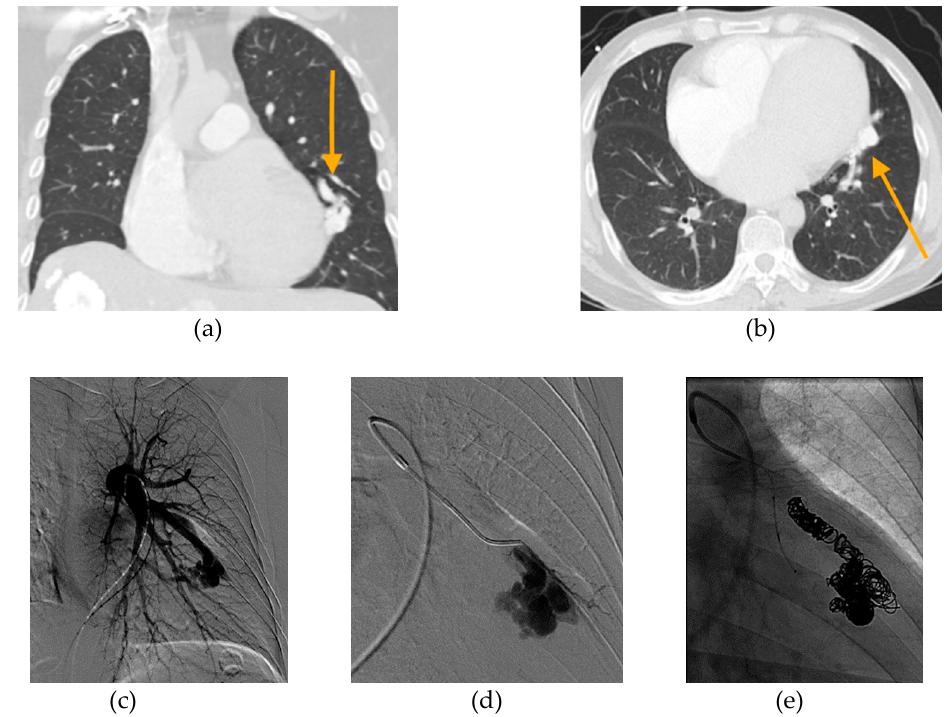
Figure 5. 49-year-old male with history of nonischemic cardiomyopathy, severe mitral and triscuspid regurgitation, PAVM, and PH presented with acute hypoxemic respiratory failure. ( a ) Axial and ( b ) coronal CT angiogram images revealing a large PAVM in the lingula (orange arrows). ( c ) Initial pulmonary angiogram of the left lung demonstrates that a large proportion of pulmonary arterial flow passes through the PAVM, acting as a “pop-off” valve. ( d ) Selective angiogram shows selection of the feeding artery with filling of the complex PAVM sac. Prior to embolization, patient’s oxygen saturation on 4 L nasal cannula was 89%. Pre-embolization main pulmonary artery pressure (PAP) was 53/21 mmHg (mPAP 33 mmHg). ( e ) Final pulmonary angiogram shows occlusion of PAVM with combined coiling and deployment of an 8 mm Amplatzer plug in the arterial feeder. Following embolization, PAP increased 72/37 mmHg (mPAP 50 mmHg). Oxygen saturation on 4 L nasal cannula improved to 99%. The patient was weaned to room air and discharged in good condition. Two years later, he was admitted on multiple occasions for acute decompensated heart failure. At 3.5 years after